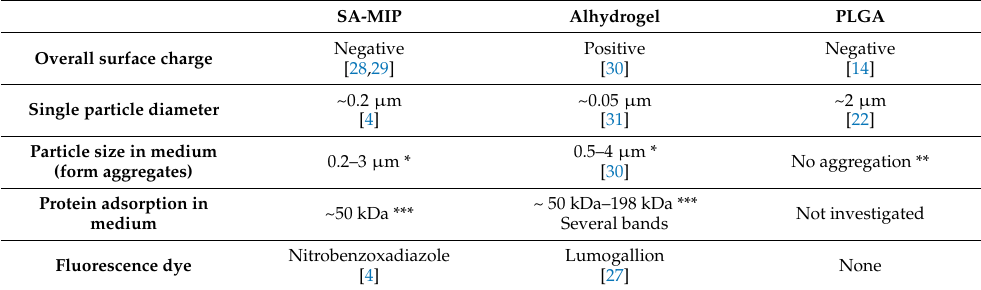
Table 1. Particle characterization of sialic acid molecularly imprinted polymers (SA-MIPs), Alhydro- gel and poly(lactic-co-glycolic acid)